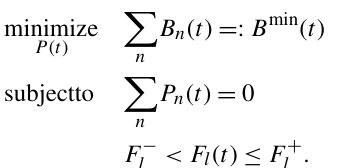
Figure 3. Growth of the backup energy need in dependency of wind/PV mix. Backup energy is normalized to the corresponding minimum